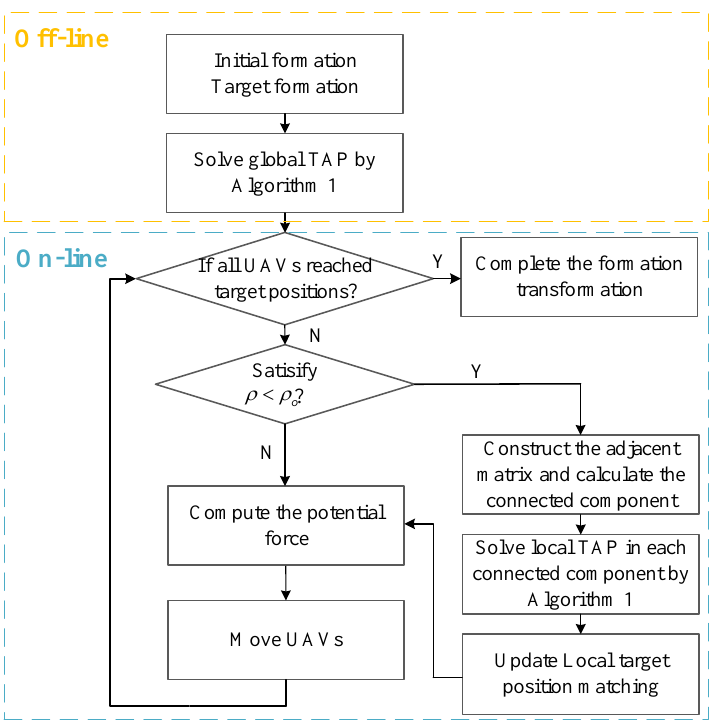
Figure 2. Detailed flow chart of the hybrid